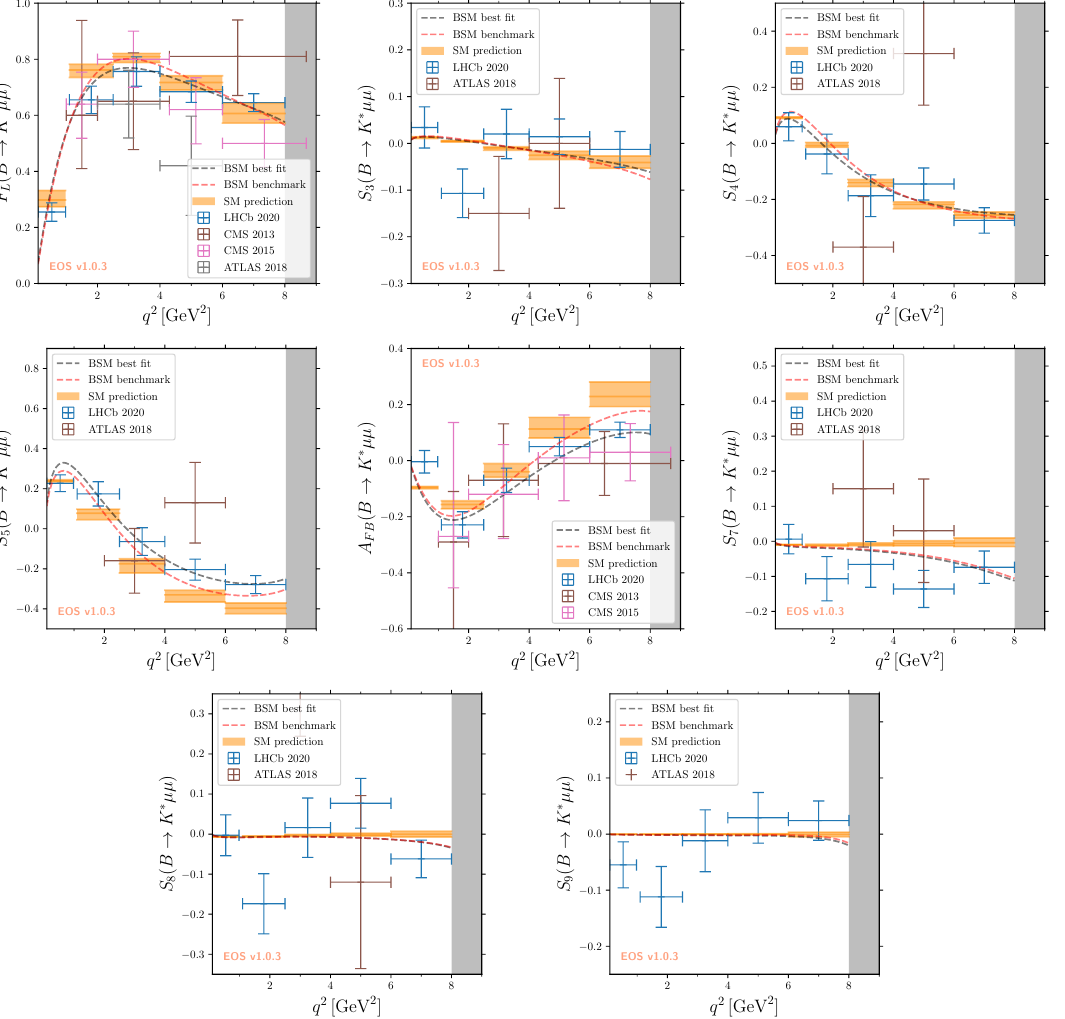
Figure 6 . SM predictions for the angular observables of the B → K ∗ µ + µ − decays. Our SM predictions are also given in table